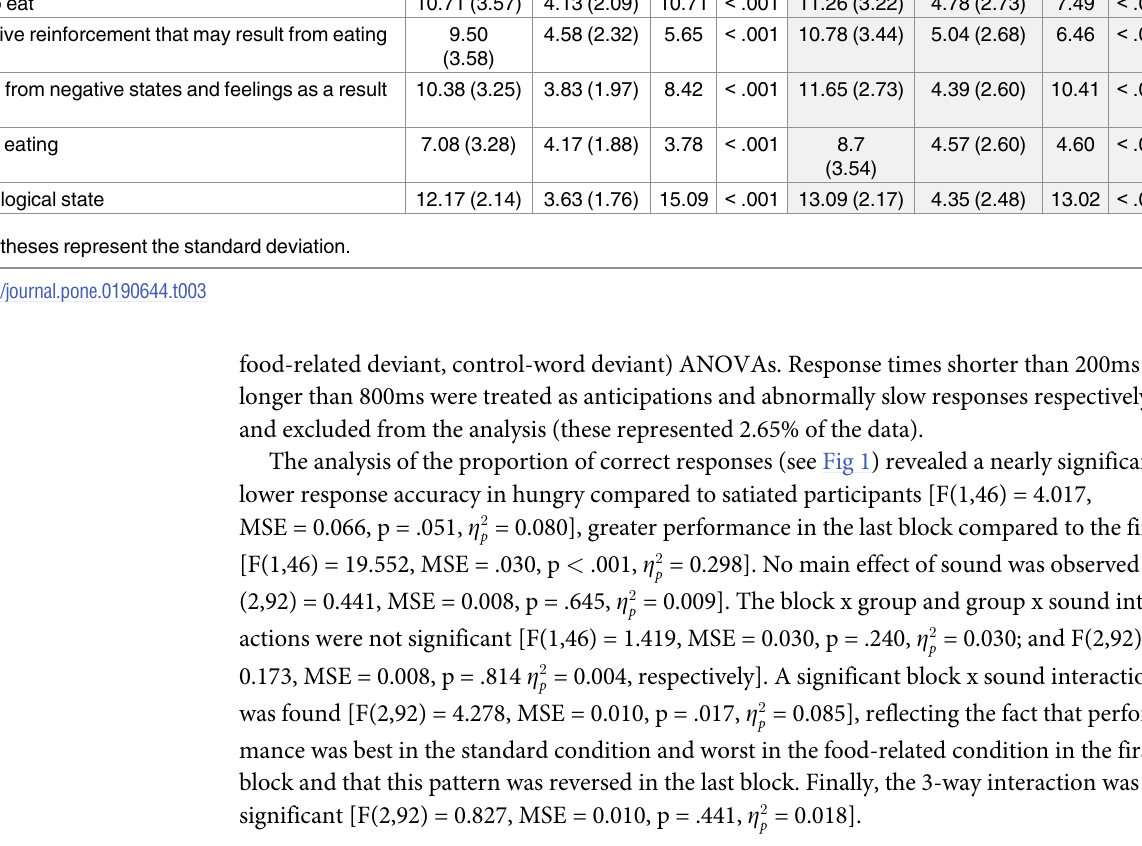
Table 3. Mean scores on the FCQ-S and its subscales for hungry and satiated participants, and corresponding statisticalcomparisons, prior to and following the administration of the cross-modal oddball task.